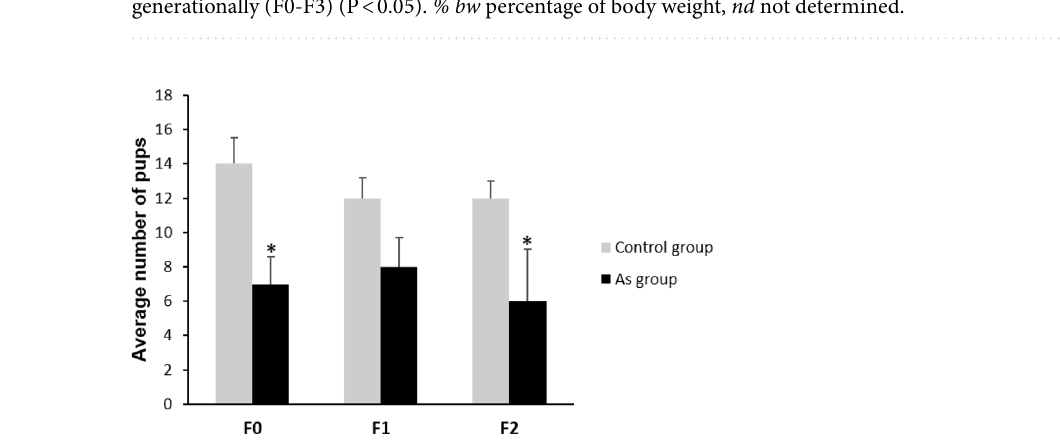
Table 2. Body weight and organ relative weight over generations in females. (*) Statistically significant differences between control and arsenic exposed group (mean ± standard deviation) compared intra-